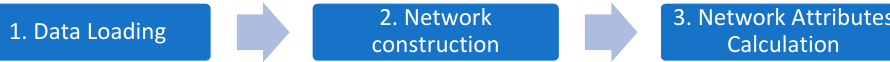
Figure 1. Description of network construction stages.